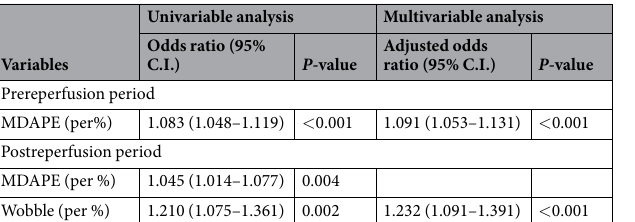
Table 3. Univariable and multivariable logistic regression analyses for in-hospital mortality. Significant risk factors were sequentially identified using univariable ( P < 0.2) and multivariable ( P < 0.05) logistic regression analyses. Abbreviations: C.I. = confidence interval; MDAPE = median absolute performance